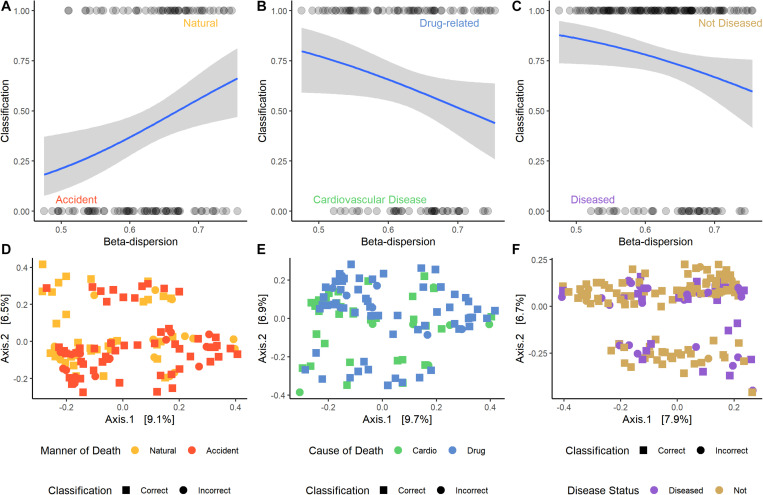
Logistic regression models of the best performing pair-wise comparisons. Nose samples were selected, as well as beta-dispersion from full communities. (A–C) Logistic regression models with a 95% confidence interval of beta-dispersion on the x-axis and the binary classification on the y-axis. (A) Accident: 0, natural: 1. (B) Cardiovascular disease: 0, drug-related: 1. (C) Disease: 0, non-diseased: 1. (D–F) Principal coordinate analysis (PCoA) plots of microbial samples included in the logistic regression model. Colors correspond with the M/COD, while shape indicates if the sample was correctly classified by the model. (D) Natural vs. accidental deaths. (E) Drug-related vs. cardiovascular disease deaths. (F) Diseased vs. non-diseased deaths.